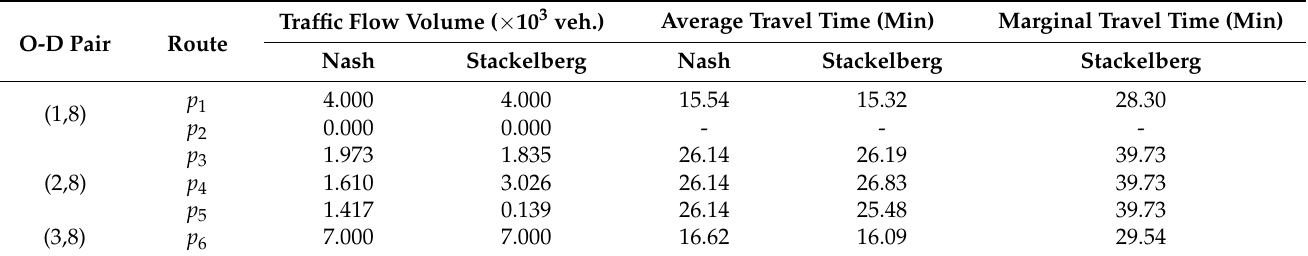
Table 3. Results of optimization with the Nash and Stackelberg approaches for movement routes in scenario #1.